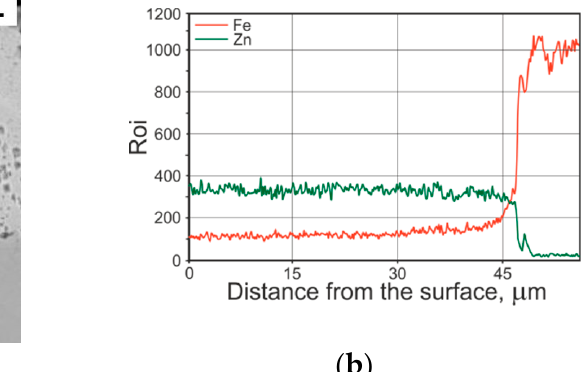
Figure 4. The microstructure observed at the cross section of the heat treated HD zinc coating deposited on disc-shaped samples: ( a ) SEM; ( b ) linear EDS analysis. Microscopic examinations (both optical—Figure 5—and scanning microscope—